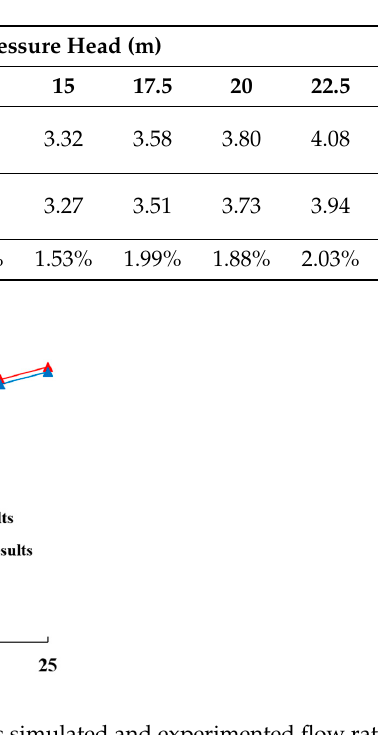
Figure 4. Curves of relationships of pressure versus simulated and experimented flow rate.